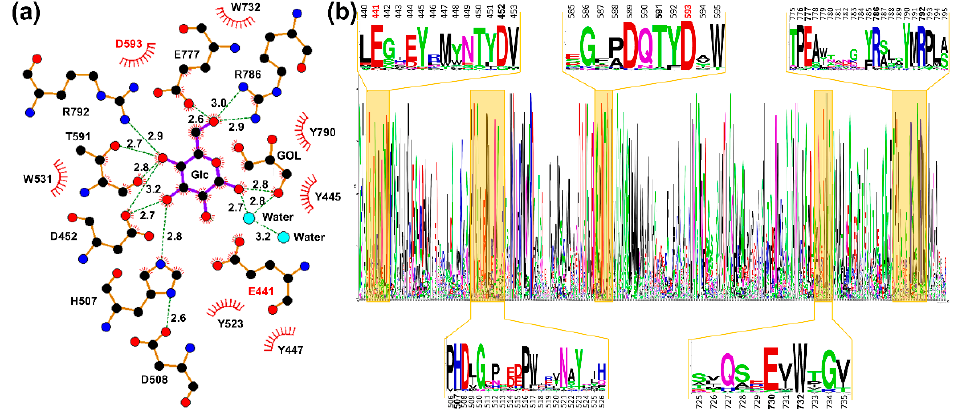
Figure 1. Tx GH116 glucose-binding residues. ( a ) Binding sites of Tx GH116 wild type structural model with glucose ligand. The ligands and protein side chains from wild type Tx GH116 bound to glucose (PDB: 5BX5) [17] are shown in a ball-and-stick representation, with the ligand bonds colored in purple and protein bonds in brown. Hydrogen bonds are shown as green dotted